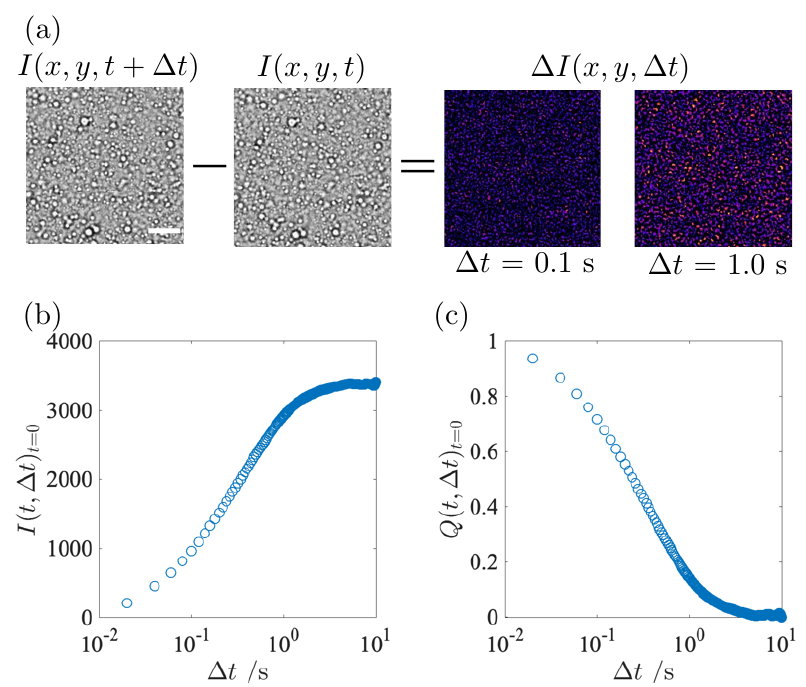
Figure 3. Representative result obtained from DVA analysis. Two images on the left side in ( a ) were taken at interval of time-lag ∆ t = 0.1 s. Image on the right side shows a differential image at two time lags ∆ t = 0.1 s and 1.0 s. Scale bar corresponds to 10 µ m. As the fat globules move with the interval ∆ t , bright spots in the differential image becomes large and increase its intensity. Time evolution of the optical intensity I ( t , ∆ t ) at t = 0 is shown in ( b ). Time evolution of I ( t , ∆ t ) is converted to Q ( t , ∆ t ) following Equation (1) in ( c ).